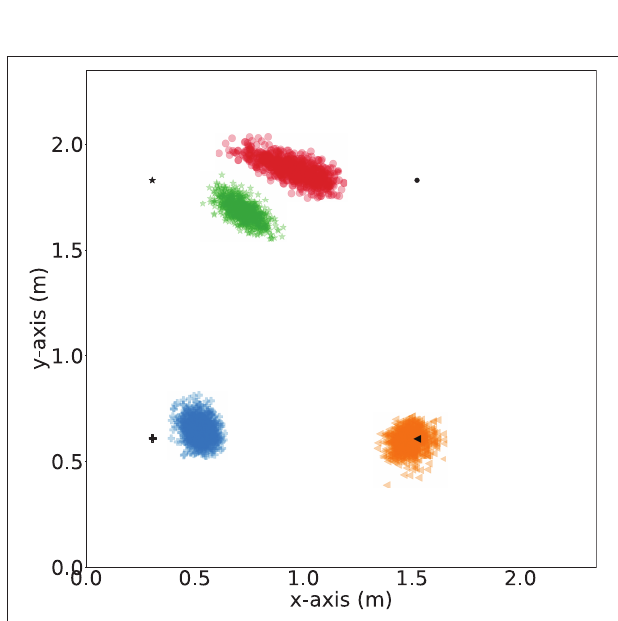
FIGURE 16 | Sensor localization visualization (with 20 iteration refinement). Blue, orange, green and red dots represent estimations of Sensor 1, Sensor 2, Sensor 3, and Sensor 4, respectively. Black dots represent ground truth